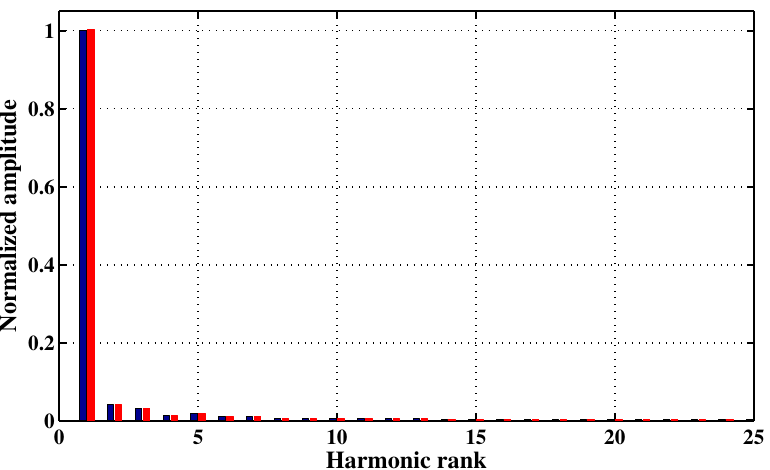
Figure 13. Phase flux linkage fast Fourier transform (FFT), where the amplitudes have been normal- ized to the one of the fundamental components in the case of the conventional armature winding arrangement. Legend: same as in Figure 12.